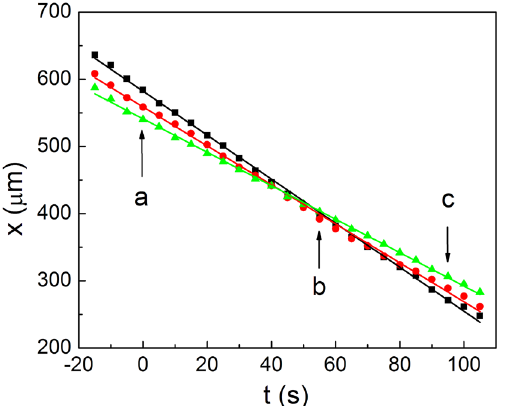
Figure 6. Temporal dependence of the x-coordinate of three droplets in Fig. 5: droplet 2 (squares), droplet 7 (circles) and droplet 5 (triangles). Moments corresponding to frames (a), (b) and (c) in Fig. 5 are indicated by